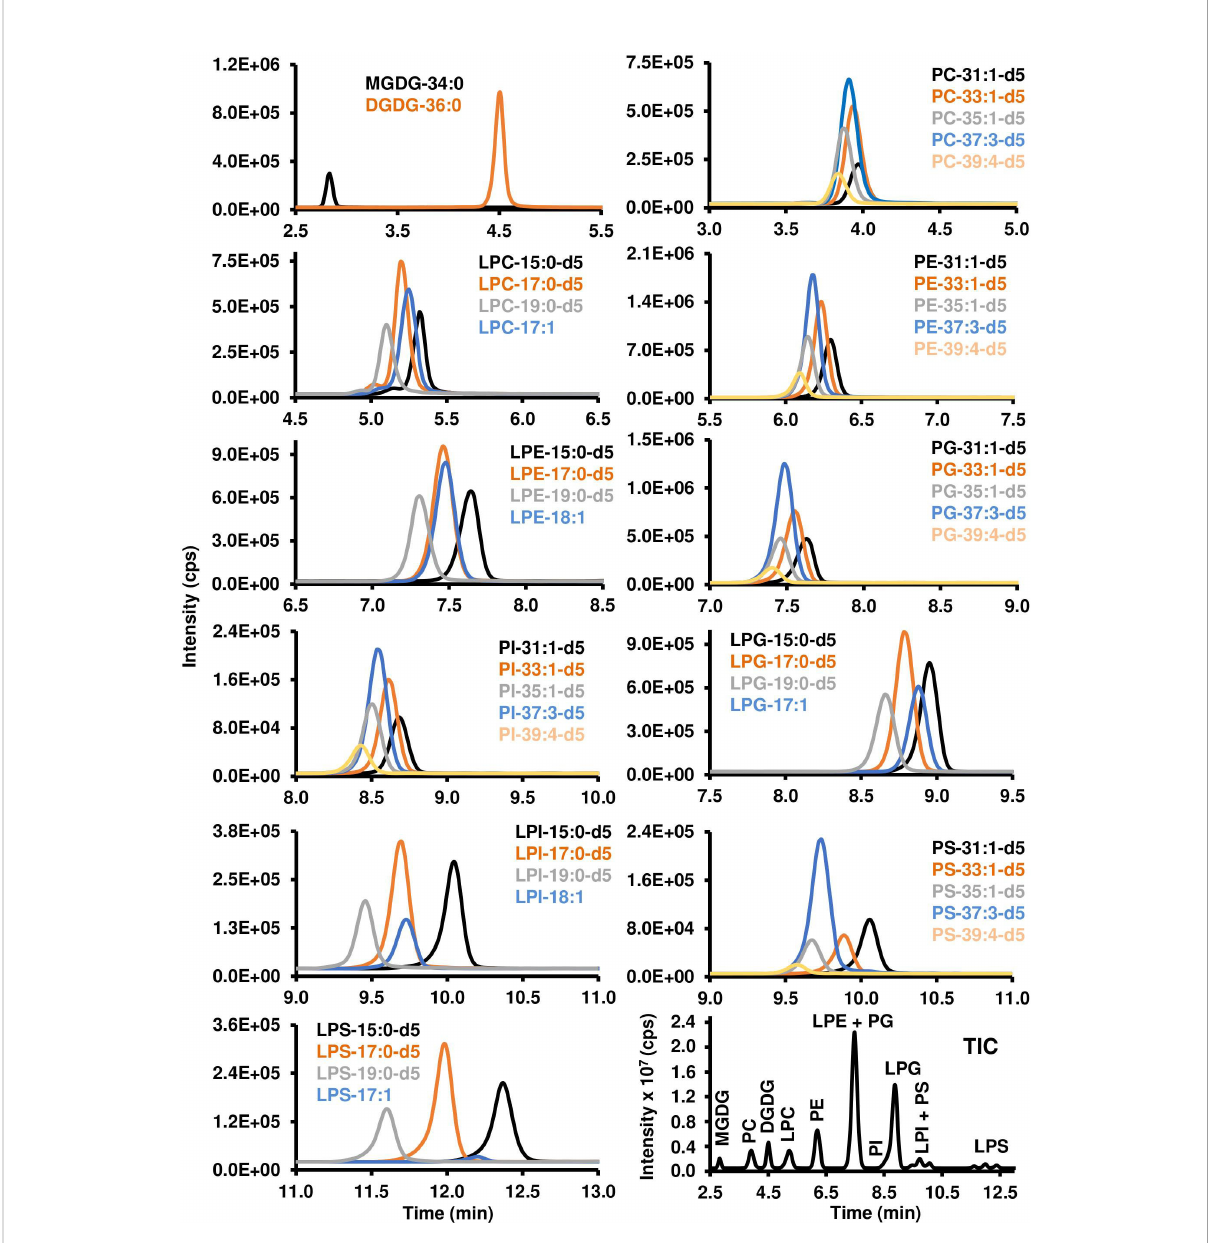
FIGURE 3 Chromatographic resolution and detection of polar lipids using LC-MS/MS. Polar lipids were detected and quanti fi ed using scheduled MRM scan survey as indicated in the Materials and Methods . XIC for each molecular species of lipid was generated using a precursor/product ion transition that is listed in Tables 1 and 2. TIC of the different classes of polar lipids is reported in the lower right corner of the fi gure. MGDG, monogalactosyldiacylglycerol; DGDG, digalactosyldiacylglycerol; PC, phosphatidylcholine; LPC, lysophosphatidylcholine; PE, phosphatidylethanolamine; LPE, lysophosphatidylethanolamine; PG, phosphatidylglycerol; PI, phosphatidylinositol; LPG, lysophosphatidylglycerol; LPI, lysophosphatidylinositol; PS, phosphatidylserine; LPS, lysophosphatidylserine. Each lipid class is characterized by its number of carbon atoms and double bonds. “ d5 ” indicates the glycerol part of the lipid has fi ve deuterium instead of hydrogen